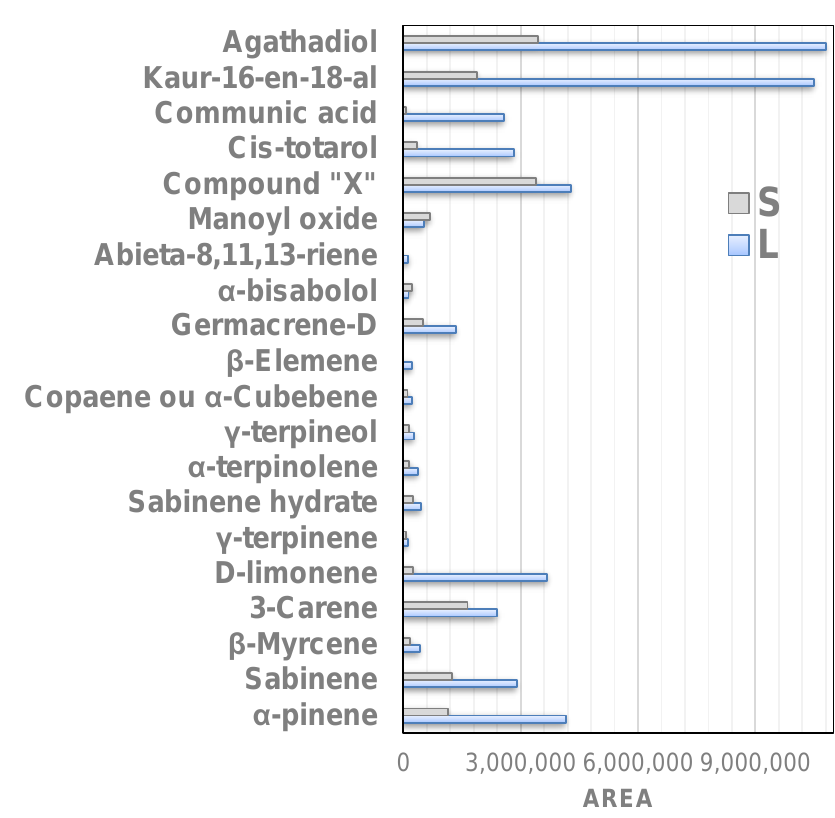
Figure 5. Main constituents of ethanolic extracts of leaves collected in trees exposed to solar light (L) and trees facing north (S). Compound “X” is (E)-3-methyl-5-((1R,4aR,8aR)-5,5,8a-trimethyl-2- methylene-deca-hydro-naphthalen-1-yl)pent-2-en-1-ol.